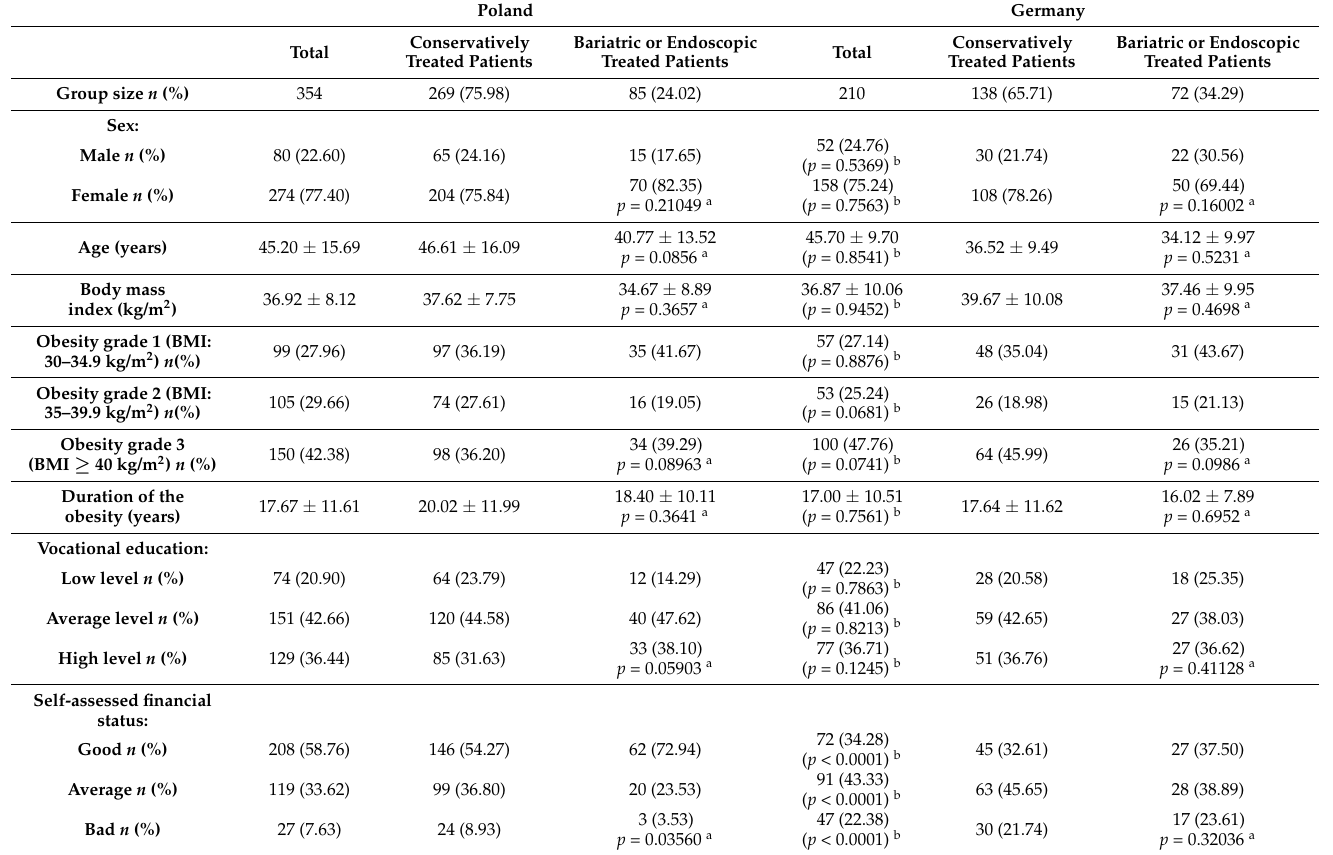
Table 1. Comparison of sociodemographic and clinical parameters between patients with obesity from Poland and Germany n =